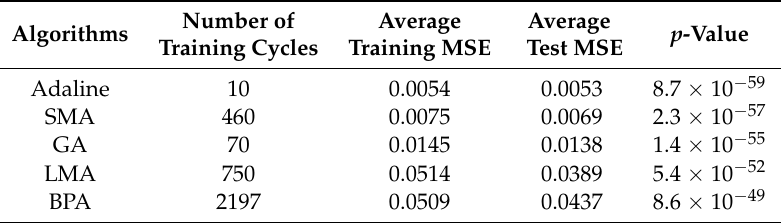
Table 4. Statistical Analysis of the Experimental